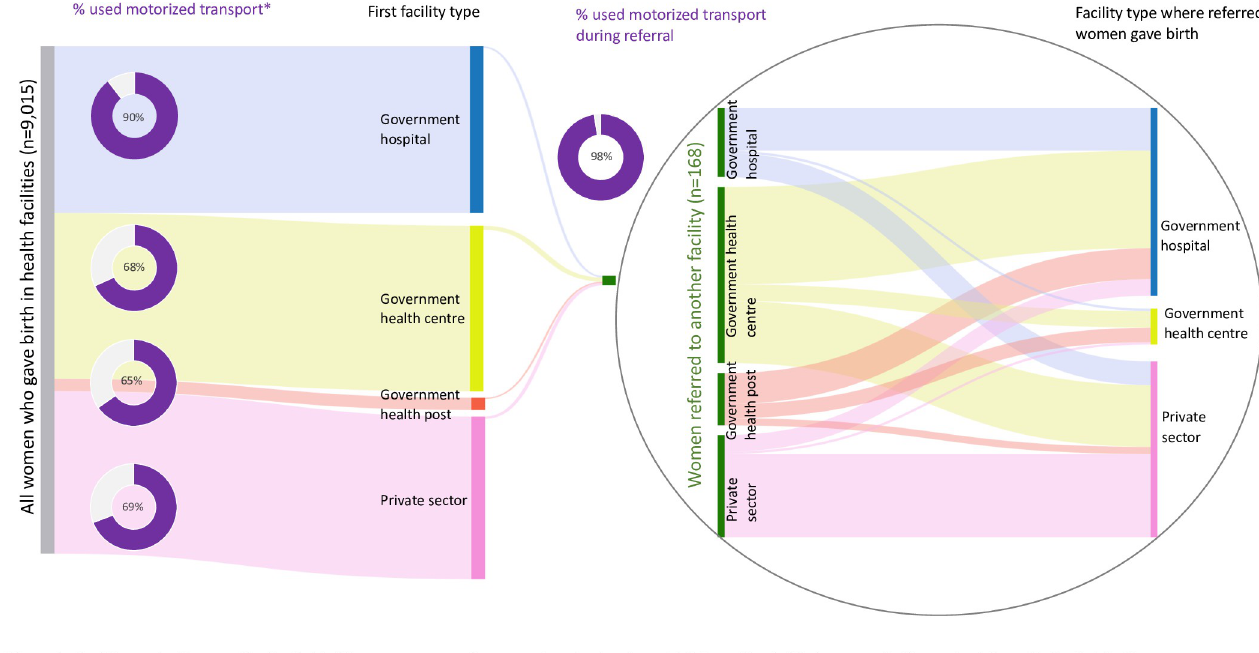
Fig 1. Pathways to childbirth care among women whose most recent live birth was in a health facility in the five-year recall period of the 2018 Nigeria DHS (N = 9,015).